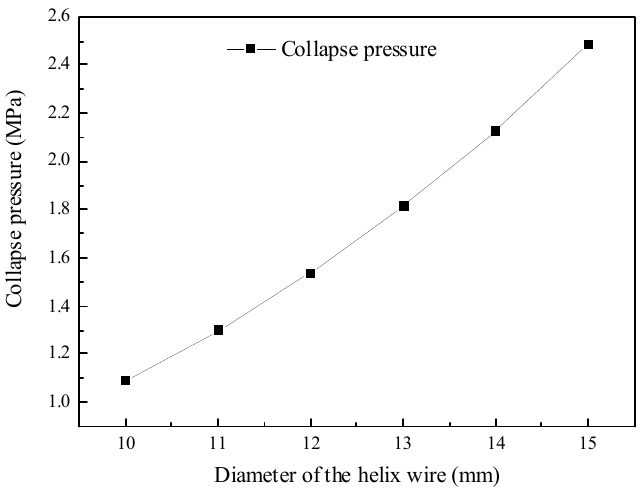
Figure 15. Collapse pressure of submarine hose corresponding to different helix wire diameters.